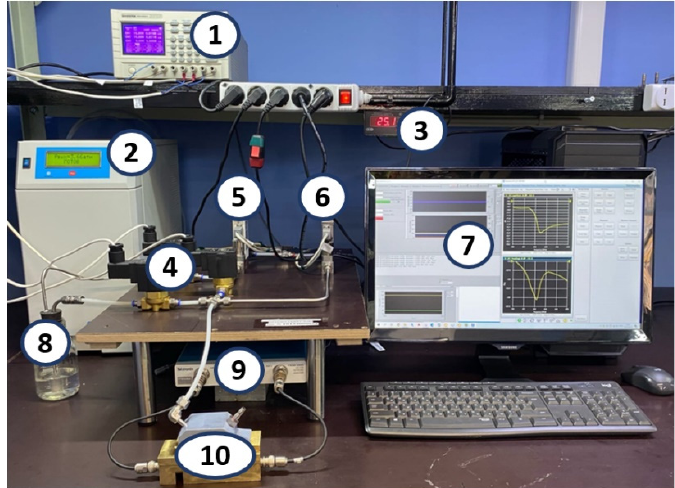
Figure 10. General view of the measuring setup. (1) 3-channel controlled power supply; (2) clean air generator; (3) chamber temperature and humidity meter; (4) electromechanical valves (5) Bronkhorst El-Flow Prestige flow meter; (6) Bronkhorst El-Flow flow meter; (7) personal computer with MOXA data acquisition board; (8) bubbler; (9) Tektronix TTR 506A vector network analyzer; (10) measuring chamber.